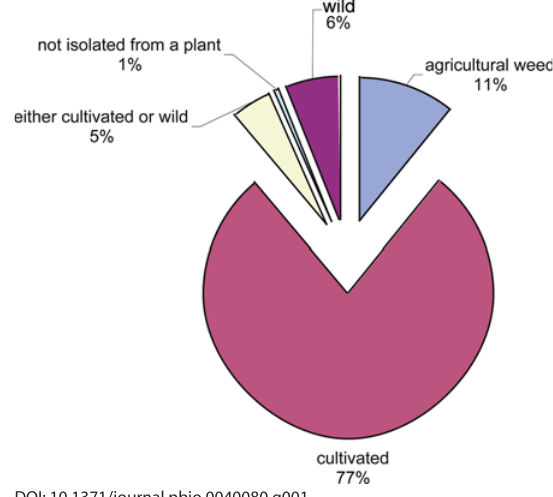
Figure 1. Frequencies of Sources of Plants from Which Recognized Plant Viruses Were Initially